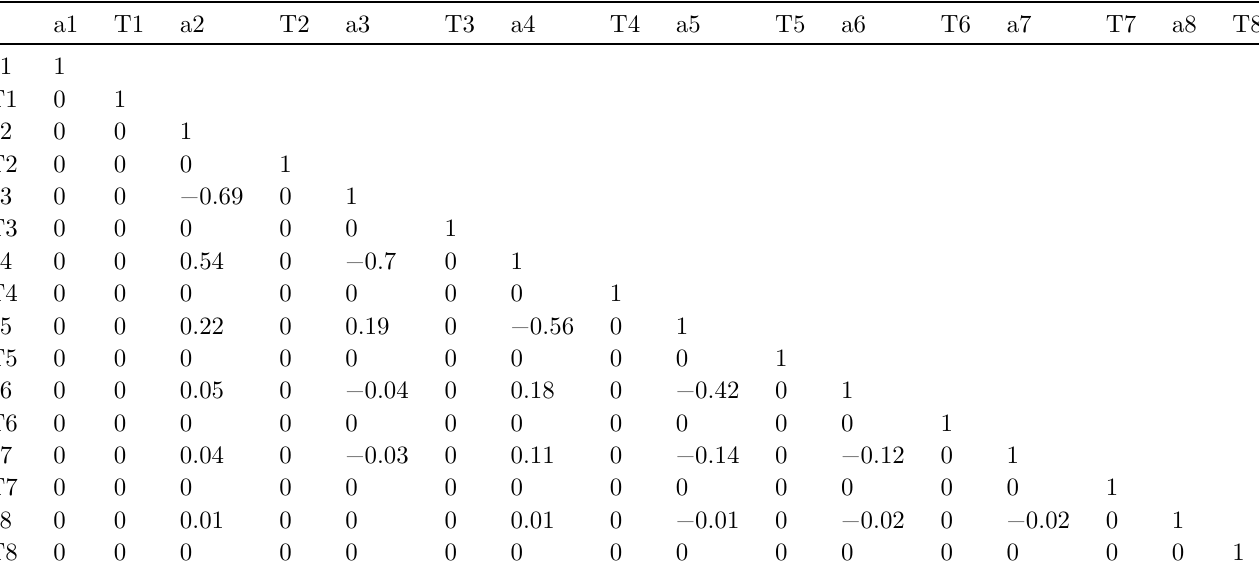
Table 6. The 8-group correlation matrix obtained in the LSF processing of the decay curve calculated with the help of the estimated 6-group DN parameters (a model decay